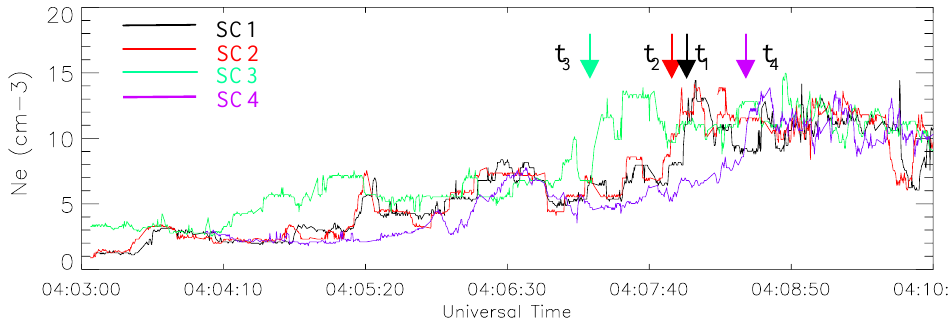
Fig. 8. Comparison of the density profiles for a short, 7min time interval during the event shown in Fig. 7. The arrows indicate the occurrence times of the main density gradient, as observed on each